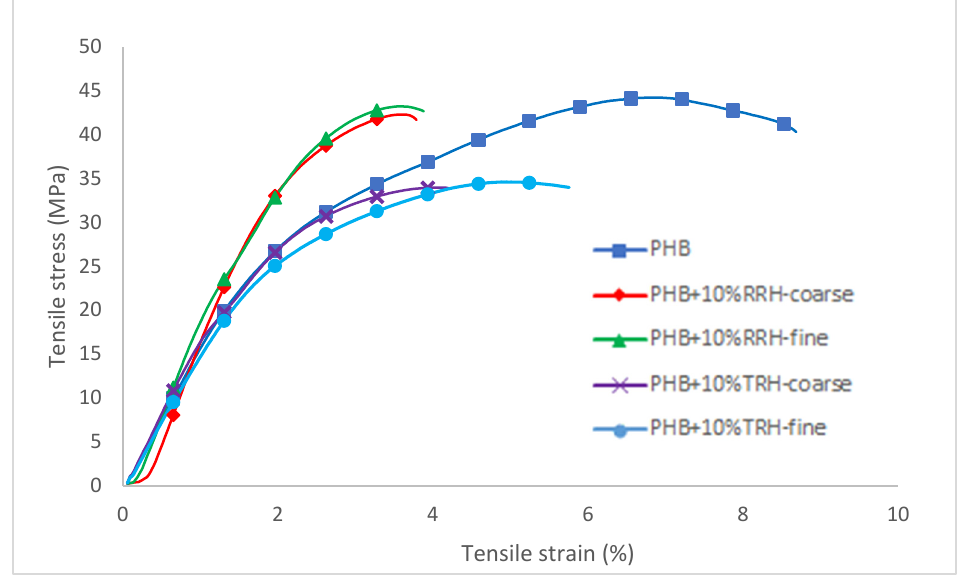
Figure 3. Stress–strain curves for tensile tests of PHB, PHB with 10% coarse RRH, PHB with 10% fine RRH, PHB with 10% coarse TRH, and PHB with 10% fine TRH composite samples.